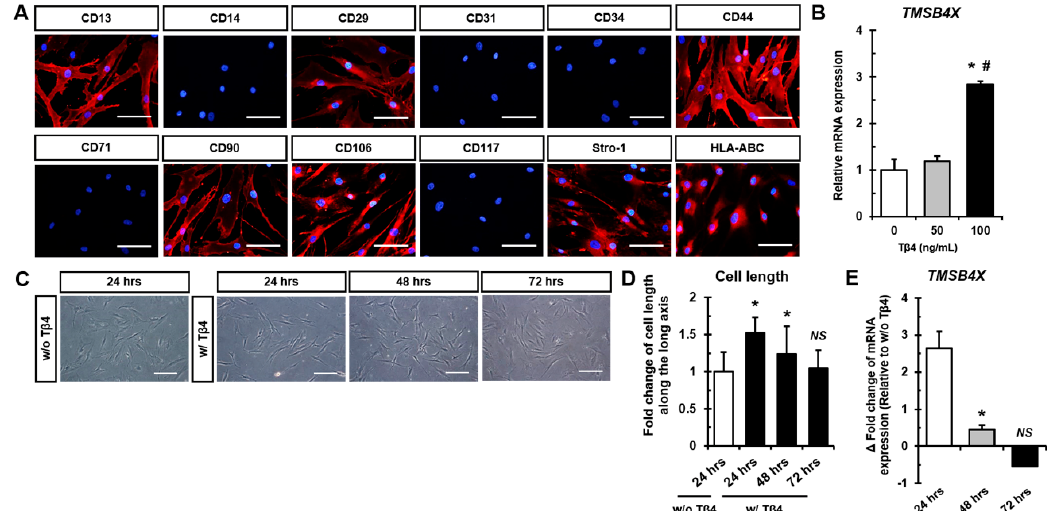
Figure 1. Treatment with T β 4 promotes morphological changes in hASCs. ( A ) Immunofluorescence images of cell surface markers in hASCs indicate positive expression for CD13, CD29, CD44, CD90, CD106, Stro-1, and HLA-ABC and negative expression for CD14, CD31, CD34, CD71, and CD117. Scale bar = 100 µ m. ( B ) Real-time PCR analysis of relative endogenous TMSB4X mRNA expression in hASCs after 24 h of dose-dependent exogenous treatment with T β 4 (0, 50, and 100 ng / mL). * p < 0.05 vs. 0 ng / mL; # p < 0.05 vs. 50 ng / mL. ( C ) Representative phase-contrast images of hASCs at 24 h, 48 h, and 72 h after a single T β 4 treatment (100 ng / mL). Scale bar = 100 µ m. ( D ) Elongated cell length after a single treatment with T β 4 at 24 h and 48 h compared to cell length of untreated cells. * p < 0.05 vs. without T β 4 treatment. ( E ) Changes in TMSB4X mRNA expression upon a single T β 4 treatment. Data are shown as ∆ (fold change of 2 − ∆∆ Ct values at 24 h, 48 h, and 72 h after T β 4 treatment compared to that without T β 4 treatment). * p < 0.05 vs. 2 − ∆∆ Ct values of without T β 4 treatment; NS , not significant; w / T β 4, with T β 4 treatment; w / o T β 4, without T β 4 treatment.